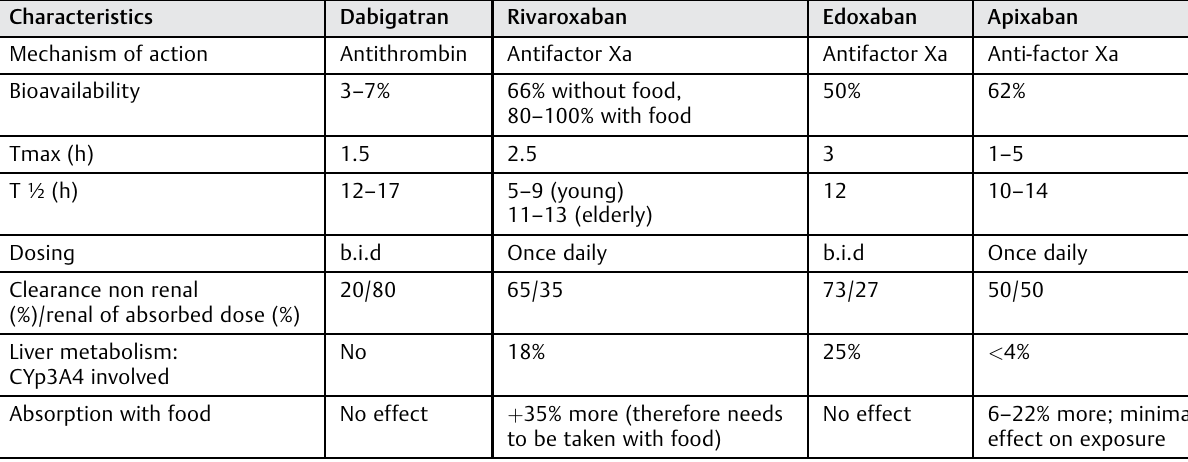
Table 1 Characteristics of different novel oral anticoagulants